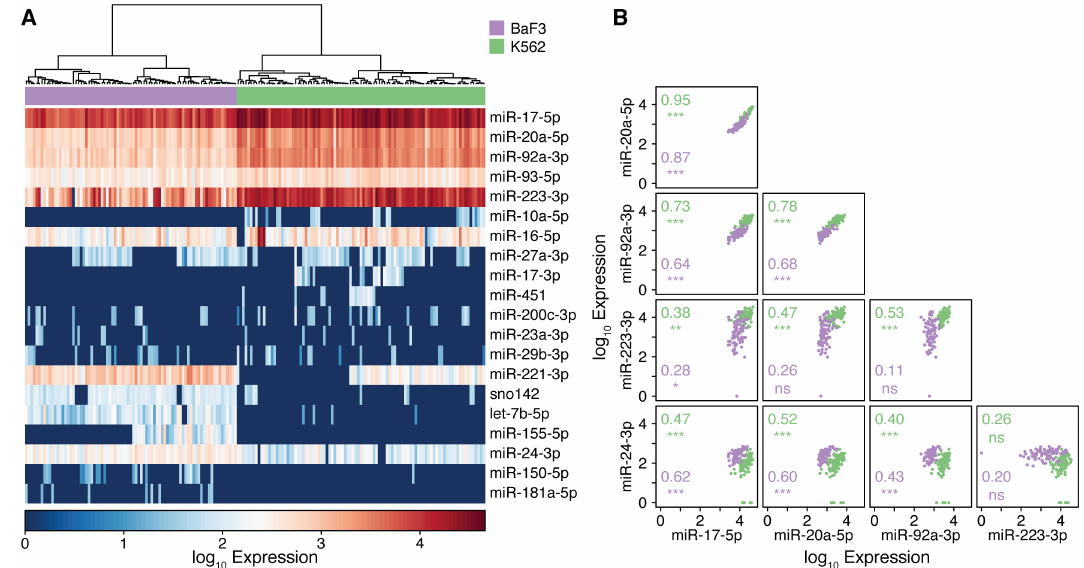
Fig 4. Single-cell miRNA expression. (A) Heatmap of expression values of 20 miRNAs in each of 95 K562 cells (green) and 81 BaF3 cells (purple). Unsupervised hierarchical clustering correctly groups the cell types based on their miRNA expression signatures. (B) Scatterplots of co-expressed miRNAs. miRNAs 17-5p, 20a-5p and 92a-3p are all strongly co-expressed as they are members of the miR-17~92 polycistronic cluster. The co-expression of miRNA 24-3p with these three miRNAs demonstrates how single-cell resolution identifies their positive regulation where bulk measurements would predict their negative regulation. Spearman correlation coefficients and their co-expression significance are denoted for each pair; (cid:3) p < 0.05, (cid:3)(cid:3) p < 0.01, (cid:3)(cid:3)(cid:3) p < 0.001, ns not significant.